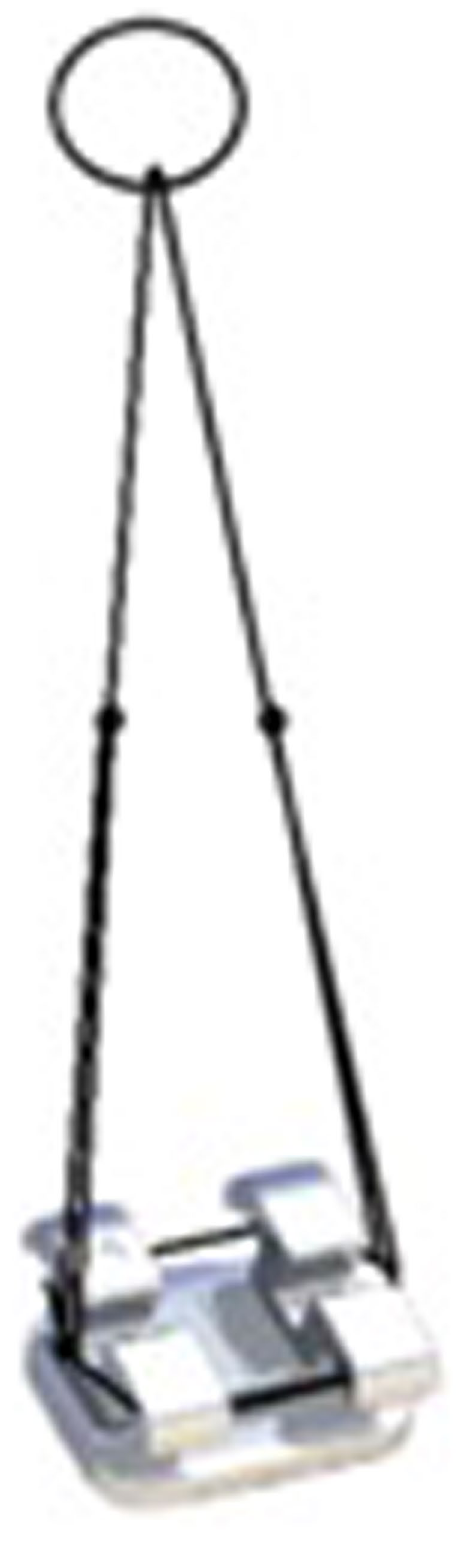
Figure 2. Application of the loops on the